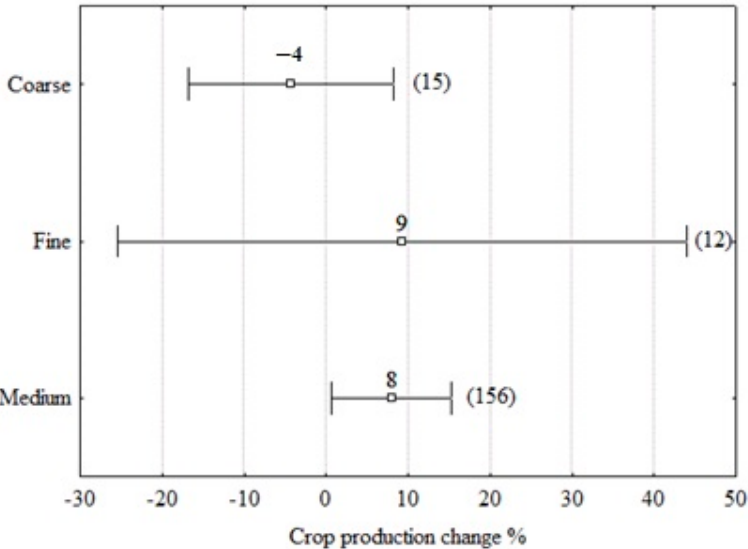
Figure 2. Mean plot of crop production change (%) in conservation tillage vs. conventional deep tillage grouped by texture group. Box—Whisker plots represent central point means, and 95% confidence interval. Numbers in brackets represent the number of comparisons used in each category.